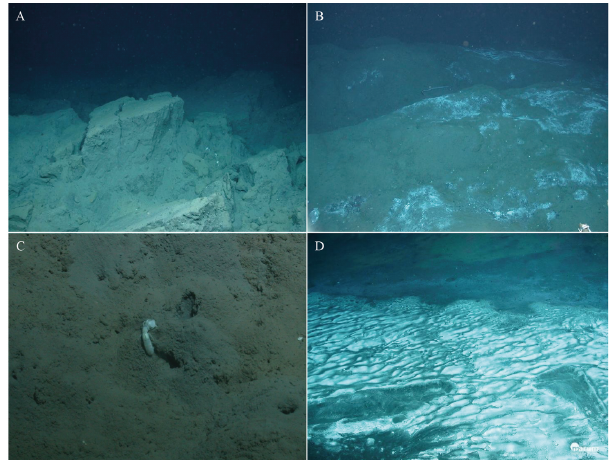
Fig. 2. Different cold-seep habitats of the Amon MV. At the central dome (I), degassing of the seafloor created bathymetric anomalies of several meters in height in 2006 (A) . Around the central dome, the seafloor becomes smoother and bacterial mats (II) are found covering the hummocks (B) . Biogenic mounds of up to half a meter in height (III) comprise the largest habitat of the Amon MV and are formed by mud shrimps (C) . A unique feature at the outer rim of the Amon MV is the lateral outflow of sulfidic muds (“sulfur band”) (D) . All pictures are copyright of MARUM,